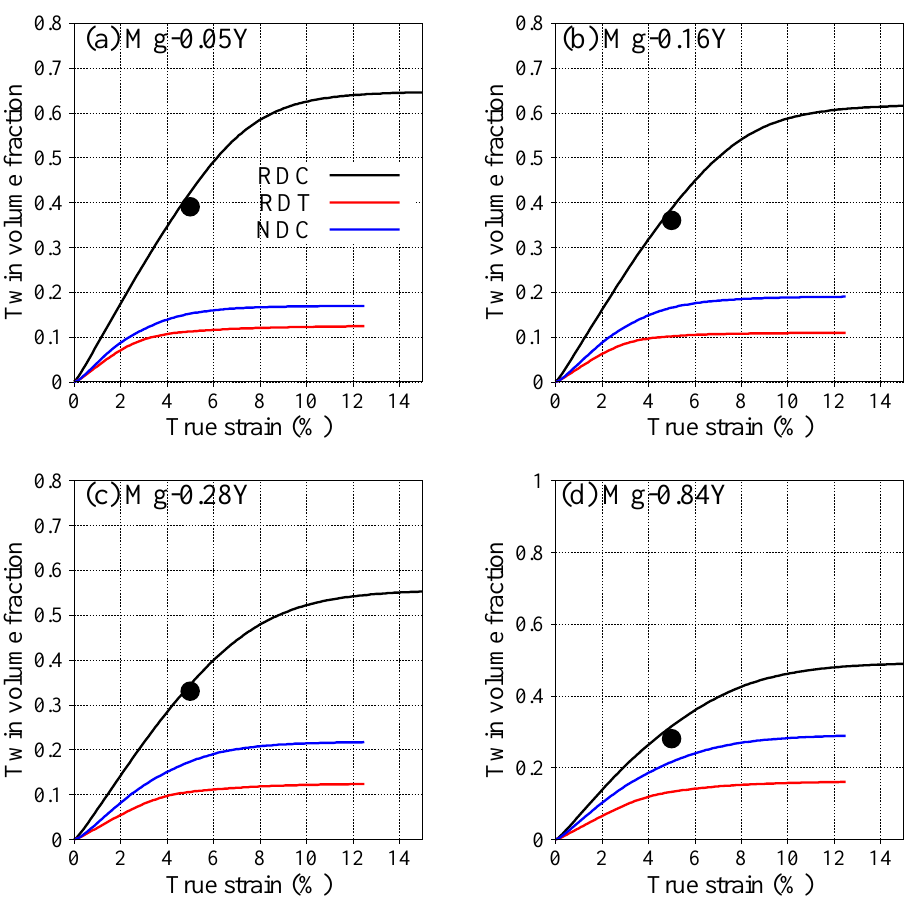
Figure 2. Evolution of twin volume fraction as a function of imposed strain for all three loading (RDC, RDT and NDC) for ( a ) Mg-0.05%Y, ( b ) Mg-0.16%Y, ( c ) Mg-0.28%Y, and ( d ) Mg-0.84%Y alloy. Here, RDC, RDT, and NDC refer to the rolling direction compression, rolling direction tension, and normal direction compression, respectively. The symbols (black dot) correspond to the experimentally measured twin area fraction from [69].